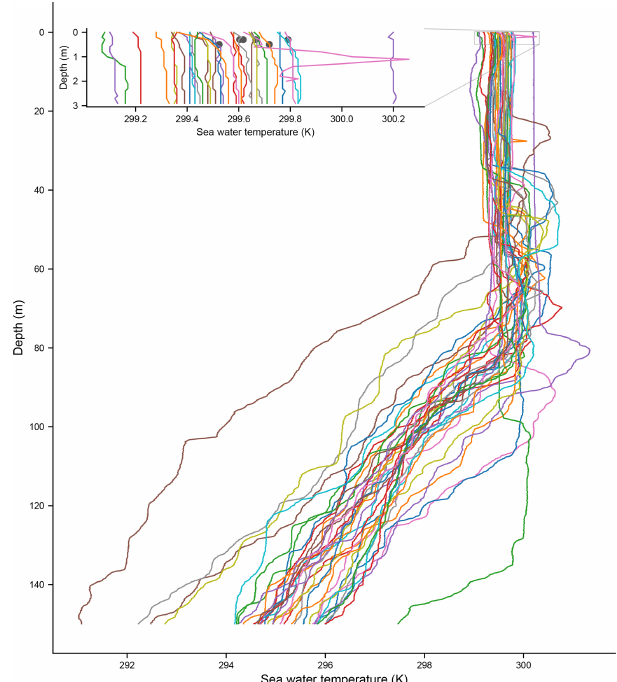
Figure 8. Profiles of air temperature (a) and relative humidity with respect to liquid (b) as obtained by dropsondes deployed from the P-3 (grey) and a radiosonde launched from the Ronald H. Brown (dark red). Dropsonde data are obtained from JOANNE (see text); radiosonde observations are obtained from the dataset described in Stephan et al. (2021). One of the 12 sondes shows much lower hu- midity from 1.5–2.5km than do the others; we are assessing all the dropsonde circles to understand if this is common or an instrumen- tal artifact.